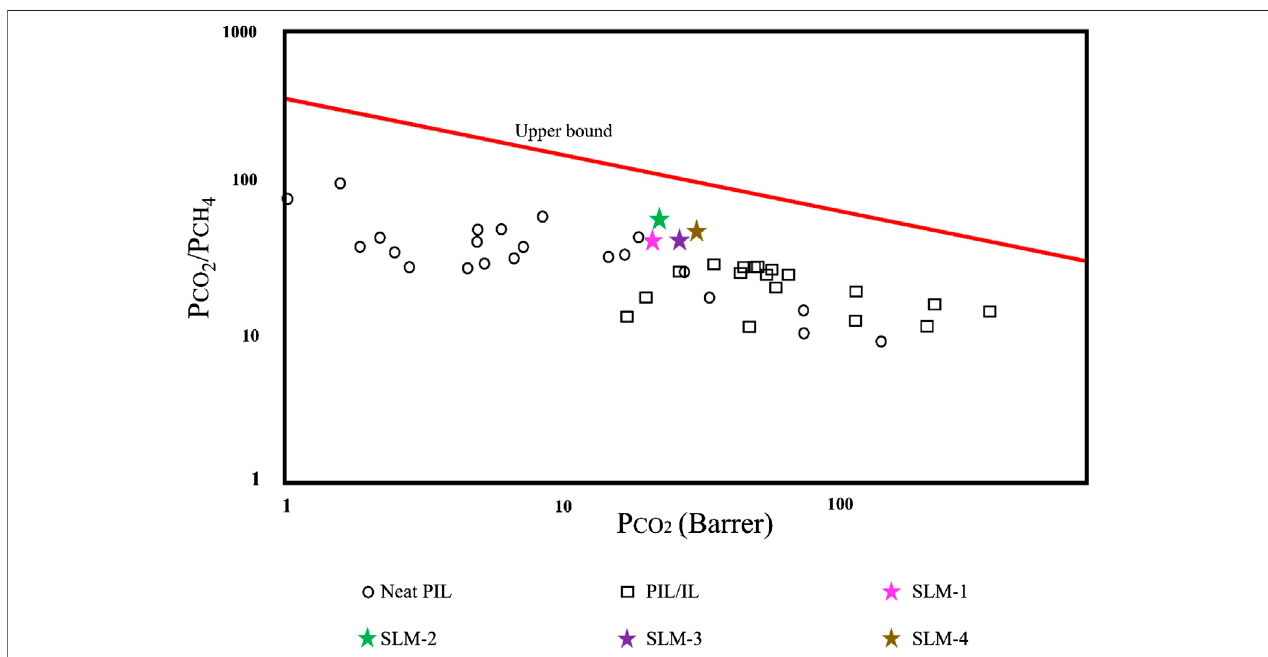
FIGURE 6 | CO 2 /CH 4 separation performance comparison on upper bound [61]. The chart is plotted on a log-log scale and PIL and PIL/IL membrane data taken from references (Bara et al., 2007; Bara et al., 2008a; Bara et al., 2008b; Bara et al., 2009a; Bara et al., 2009b; Tomé et al., 2013a; Tomé et al., 2013b; Carlisle et al., 2013; McDanel et al., 2014; Horne et al.,